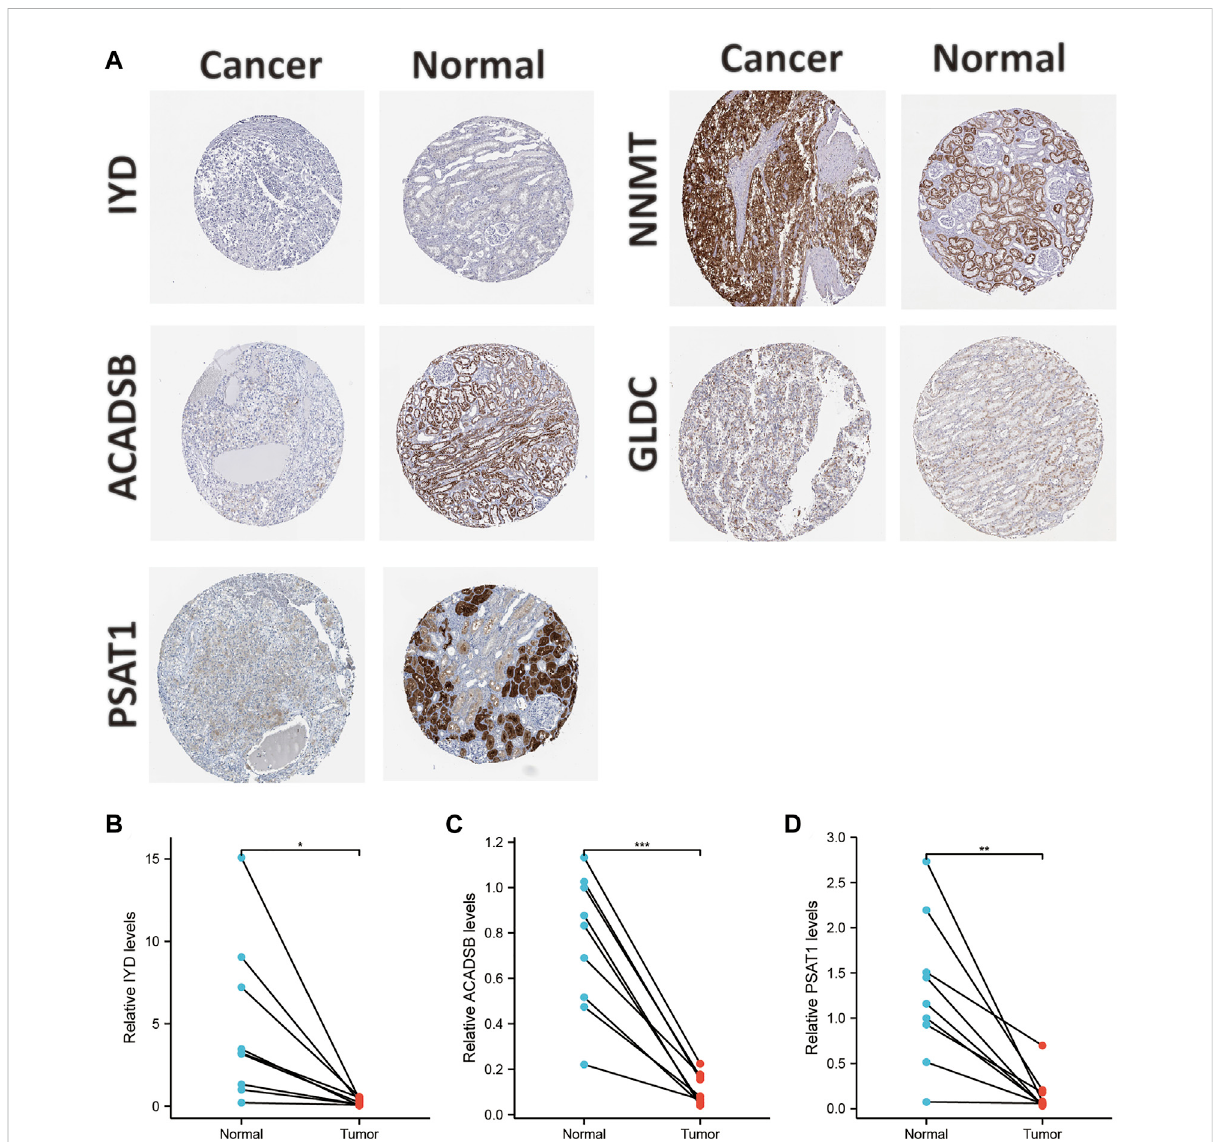
FIGURE 12 ValidationoftheproteinexpressionlevelsofAAM-relatedprognosticgenesviaIHCinHPAdatabase (A) ;Validationofthegeneexpressionlevels of IYD (B) , ACADSB (C) , and PSAT1 (D) based on ccRCC and adjacent tissues via RT-PCR, ns: p ≥ 0.05; *: p < 0.05; **: p < 0.01; ***: p <